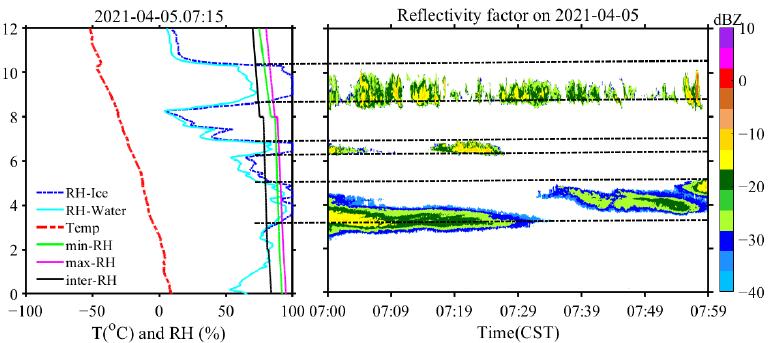
Figure 6. Three-layer cloud detected by the radiosonde and MMCR on 5 April 2021 (radiosonde temperature and RH profile ( left ), reflectivity factor THI from the MMCR ( right